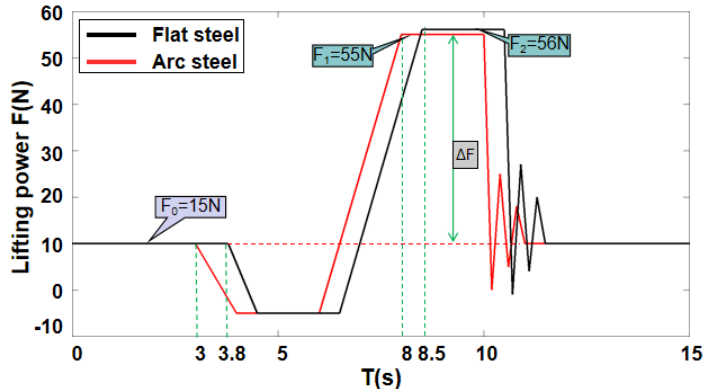
Figure 12. Flexible force test on two cases.